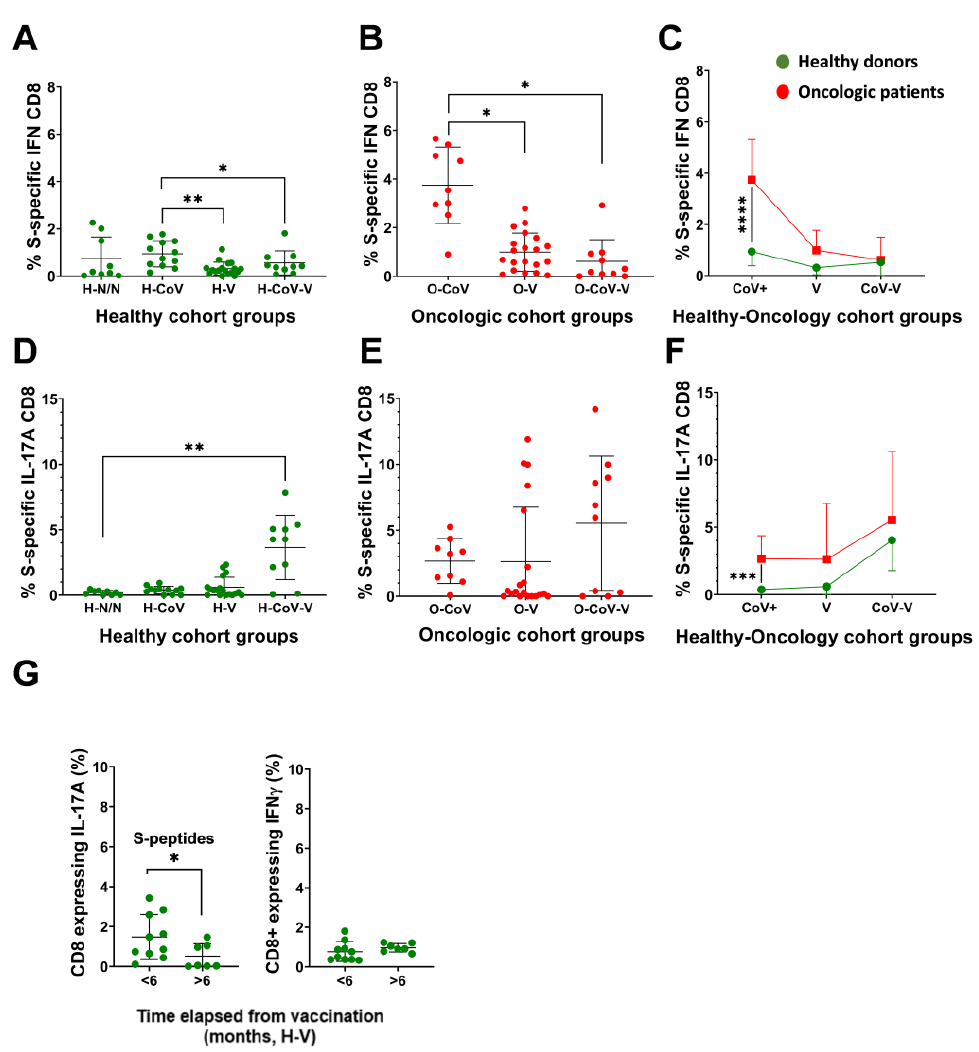
Figure 5. IFN γ and IL-17 expression in CD8 T-cells specific for the S protein . Paired backgrounds from technical controls were removed from the data. ( A – C ) Percentage of IFN γ -CD8 T-cells specific for the S protein in healthy donors and oncologic patients. ( D – F ) Percentage of IL-17-CD8 T-cells specific for the S protein in healthy donors and oncologic patients. ( A , B , D , E ) Statistical significance was evaluated with the Kruskal–Wallis test, followed by Dunn ´ s pair-wise comparisons. ( G ) Percentage of CD8 T-cells expressing IL-17 and IFN γ expression in H-V donors that completed the vaccine regime before sample collection in the indicated timelines. ( C , F , G ) Significance was tested with the Mann– Whitney U-test. H-N/N—non-vaccinated, non-COVID-19 donors; H-CoV—healthy donors with previous COVID-19 infection; H-V—vaccinated healthy donor; H-CoV-V—vaccinated healthy donor with previous COVID-19; O-CoV—oncologic patient with previous COVID-19; O-V—vaccinated oncologic patients; O-CoV-V—vaccinated oncologic patients with previous COVID-19; *, **, *** and **** indicate significant ( p < 0.05), very significant ( p < 0.01), highly significant ( p < 0.001) and very highly significant ( p < 0.0001) differences,